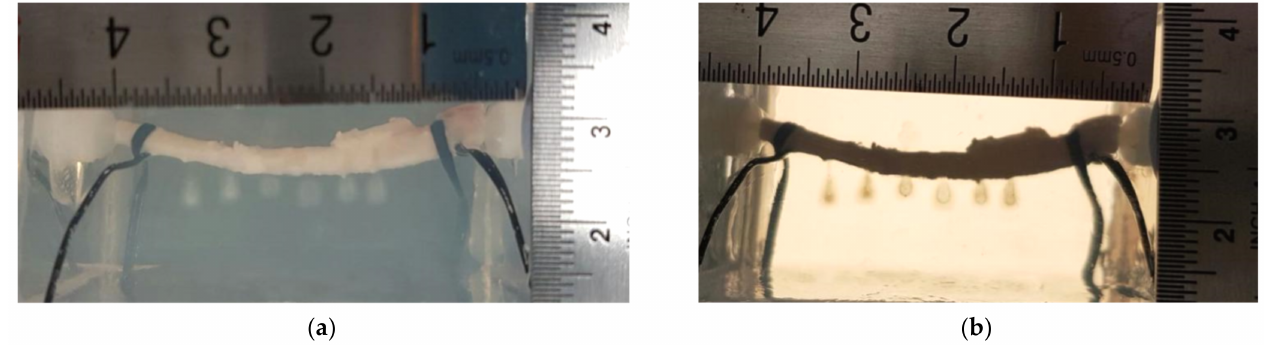
Figure 7. Representative images of HIFU-induced lesions with the HIFU focus aligned to the anterior artery wall using the ( a ) reflecting light and ( b ) transmitting